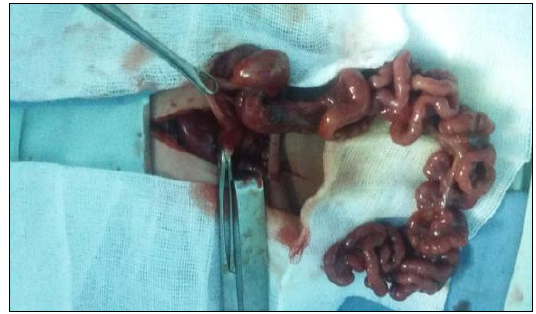
Figure 2: Apple peel configuration in addition to duodenal atresia. Multiple atresias were also present throughout length of small